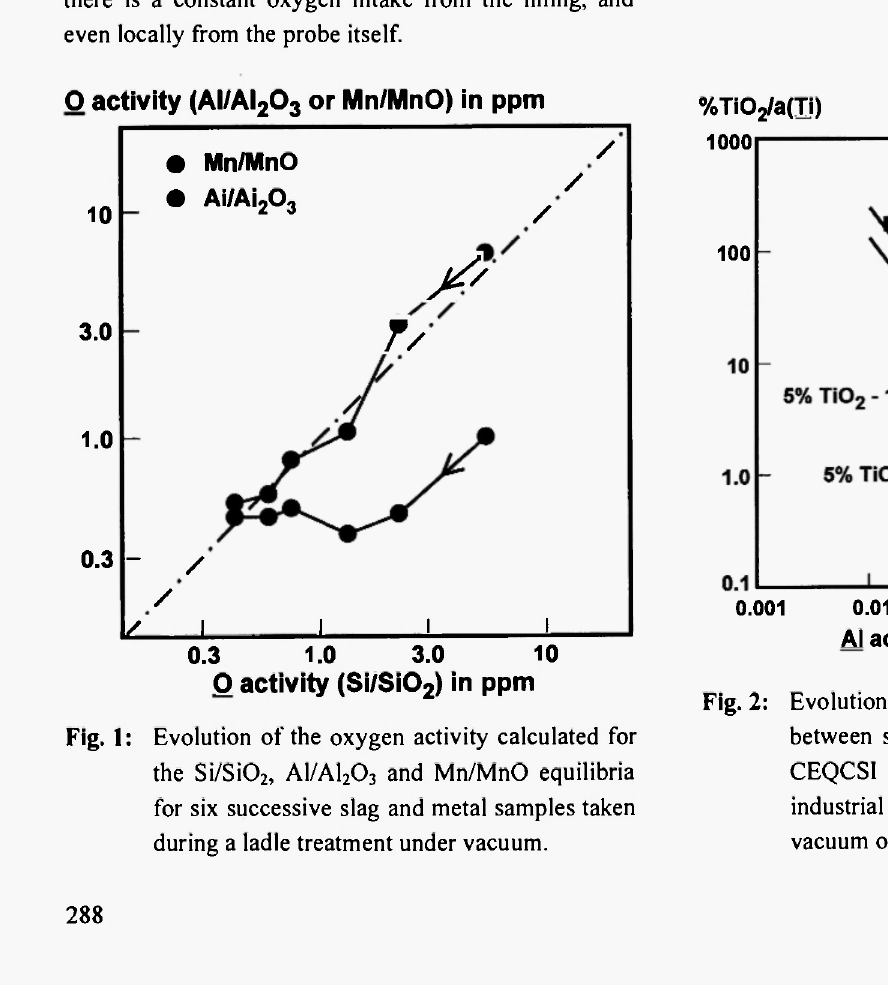
Fig. 1: Evolution of the oxygen activity calculated for the Si/Si0 2 , A1/A1 2 0 3 and Mn/MnO equilibria for six successive slag and metal samples taken during a ladle treatment under vacuum.